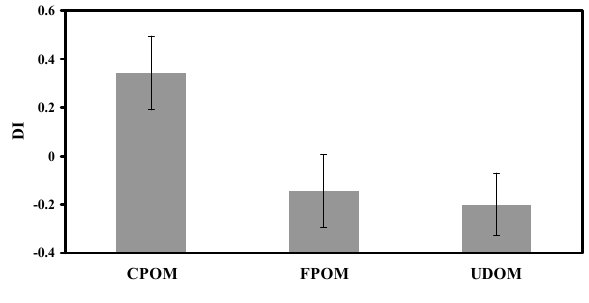
Fig. 4 Fig. 4. Diagenetic index (DI) for the coarse particulate (CPOM), fine particulate (FPOM), and ultrafiltered dissolved organic mat- ter (UDOM) size fractions. Bars represent standard deviations.